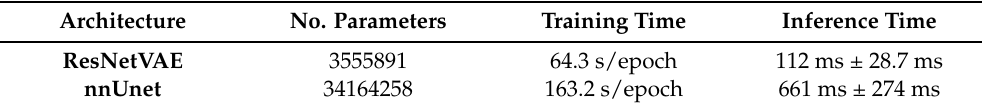
Table 2. Training and inference statistics for the trained network architectures. Training is performed on batches of 128 images of size [256, 256] in parallel on two TITAN RTX GPUs with 24 GB of memory each. Inference time statistics are measured on seven runs of a batch of one